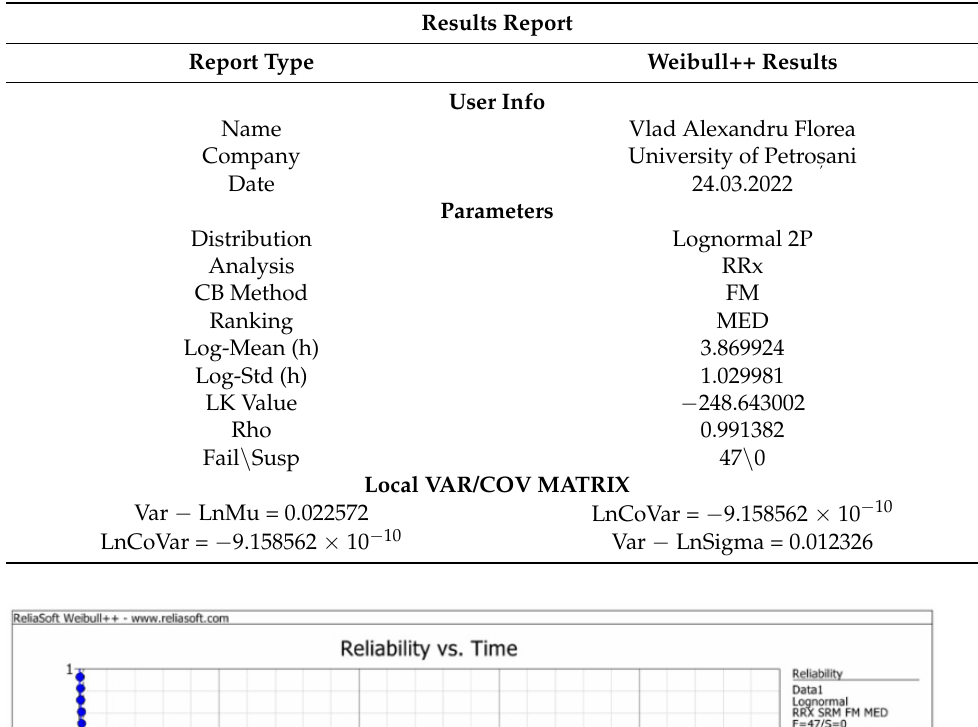
Table 8. Adopted normalized lognormal repartition law parameters for the shearer picks.